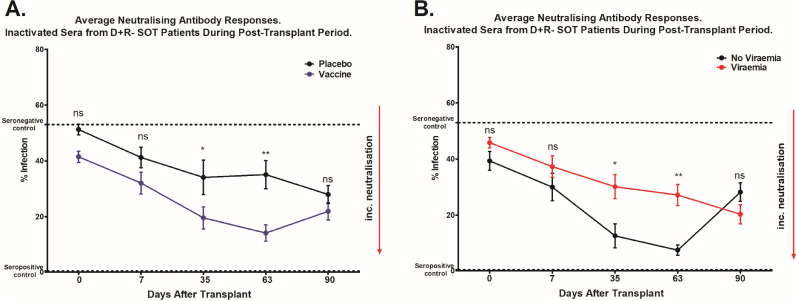
Sera collected during post-transplant period show superior neutralization capacities of vaccinated seronegative transplant patients in comparison to placebo.Strain Merlin was incubated with sera from seronegative patients, or pooled patient seropositive or seronegative sera as controls (n = 6) and used to inoculate HFFs in vitro (MOI=1). Infection was measured by IE staining and the proportion of infected cells calculated by counterstaining nuclei with DAPI. A) The average percentage infection of all the vaccinated and non-vaccinated heat inactivated patient sera; vaccine recipients are shown in blue (lower line) and those who received placebo are shown in black (upper line) B) The average percentage infection of all the vaccinated and non-vaccinated heat inactivated patient sera; patients who developed viraemia post-transplant are shown in red (upper line) and those who did not are depicted in black (lower line). Serum samples were collected at the time of transplantation and on days: 7, 35, 63 and 90 post-transplant. A comparison of neutralisation at each timepoint was performed by Mann U Whitney Test. *p<0.05, **p<0.01 and ns=non-significant difference.